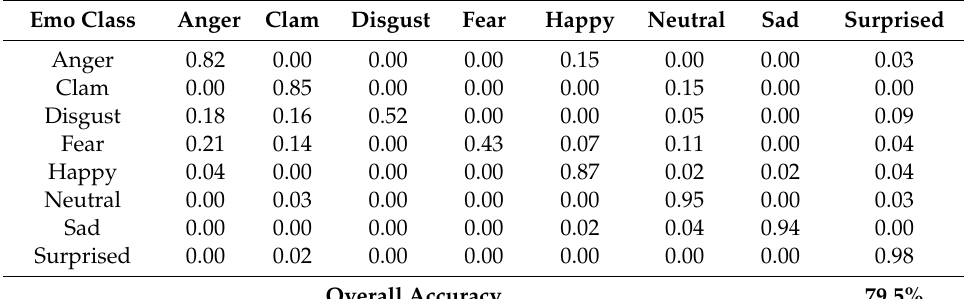
Table 5. Confusion matrix for emotions prediction on RAVDESS with average recall value (79.5%) and each row indicated the confusion of each emotion with ground truth and predictions.